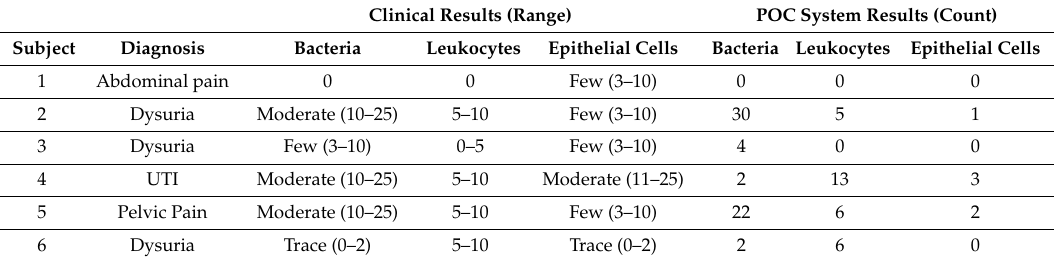
Table 1. Comparison of the count performed by the point-of-care (POC) system to the clinical results. Clinical Results (Range) POC System Results